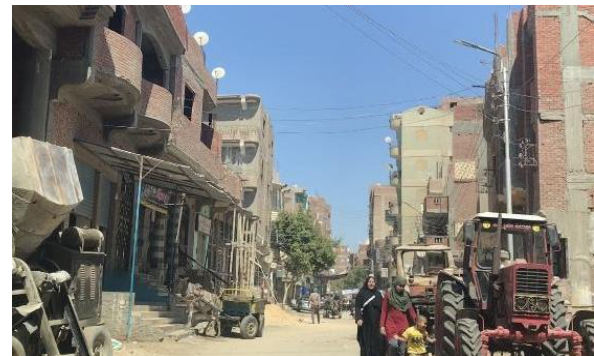
Figure 14. Lahun village main street,